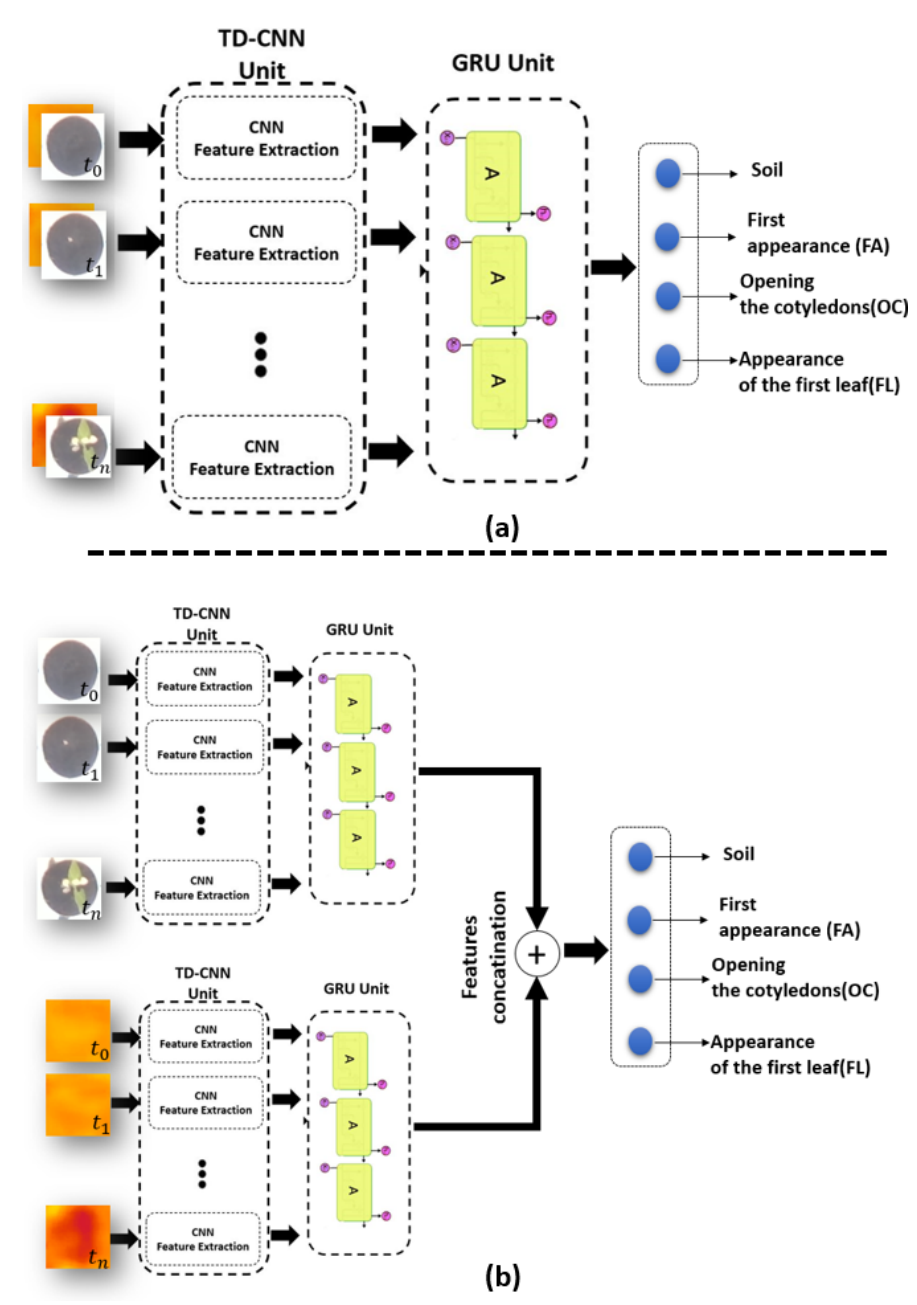
Figure 4. ( a ) TD-CNN-GRU architecture of image fusion for RGB-Depth, ( b ) TD-CNN-GRU architec- ture of features fusion for